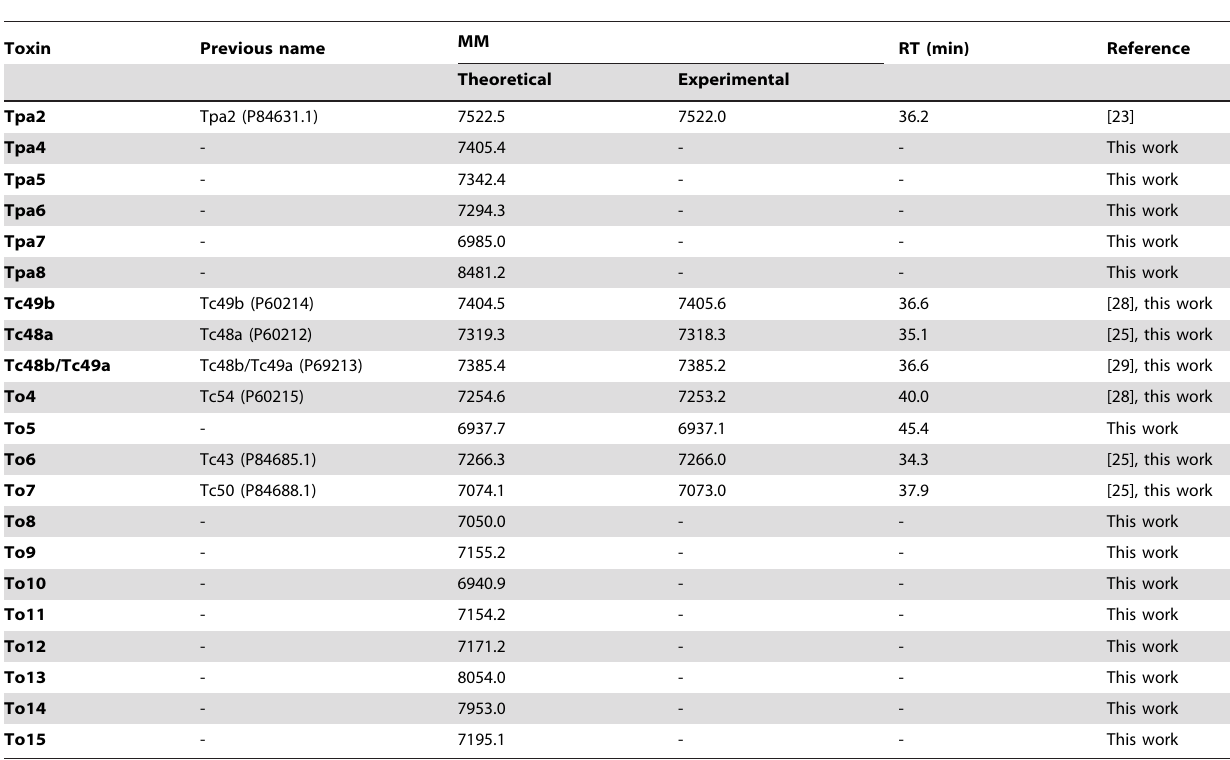
Table 1. Toxins from T. pachyurus and T. obscurus and their average molecular masses and retention times (RT).